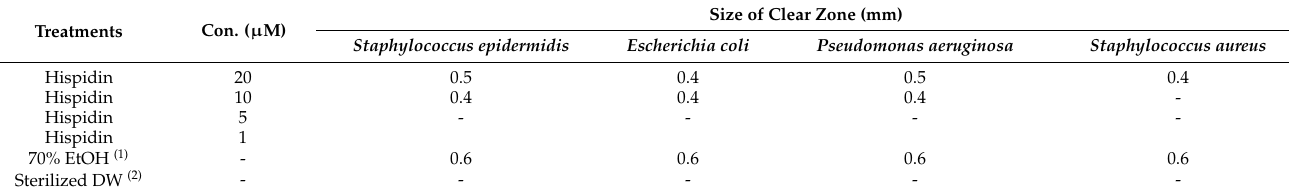
Table 1. Antibacterial activity according to paper disc